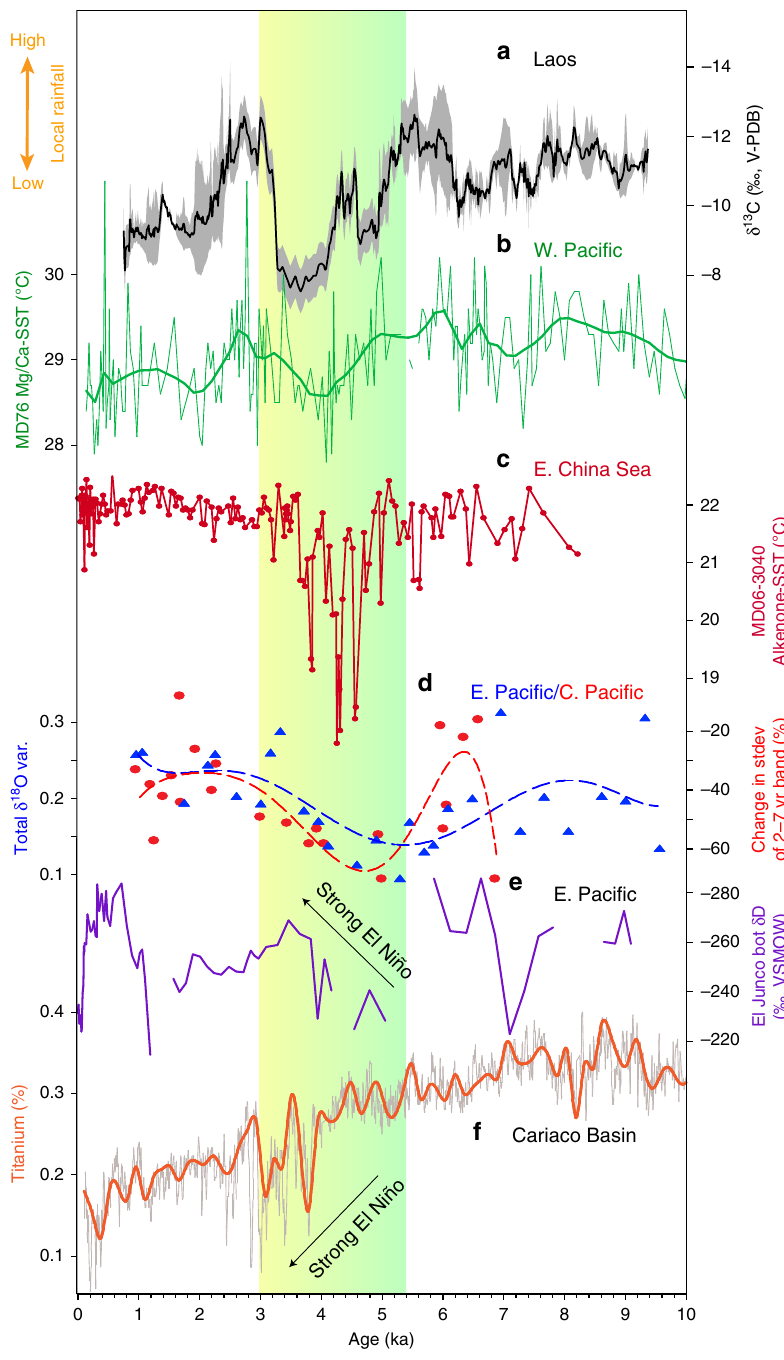
Fig. 4 Mainland southeast Asian hydroclimate and ENSO variability. a Northern Laos composite δ 13 C record (black line) and 1 σ uncertainty (gray shading) from Tham Doun Mai speleothems. b , c Mg/Ca- and alkenone-inferred sea-surface temperature (SST) records from western Paci fi c marine cores MD76 43 and MD06 – 3040 73 , respectively. d δ 18 O variance (var.) of individual G. ruber planktonic foraminifera from core V21 – 30 (blue triangles; eastern Paci fi c) 74 and relative ENSO variance changes inferred from fossil coral δ 18 O [calculated from sliding 30-yr windows of the standard deviation (stdev) of the 2- to 7-year band, and plotted as percent (%) differences from 1968 – 1998 C.E. intervals of modern coral δ 18 O] in Fanning Island and Christmas Island (red circles) located in the central Paci fi c 55 . Dashed lines show 6 th order polynomial regression. e El Junco (Galapagos) δ D of botryococcenes 56 (bot), interpreted to re fl ect shifts in ENSO variance. f Bulk titanium content of marine sediments from ODP site 1002 75 where lower values indicate drier conditions typical of El Niño events. Vertical color bar indicates the transition from a wet to a dry Sahara between 5.5 and 3.5 ka 2,3